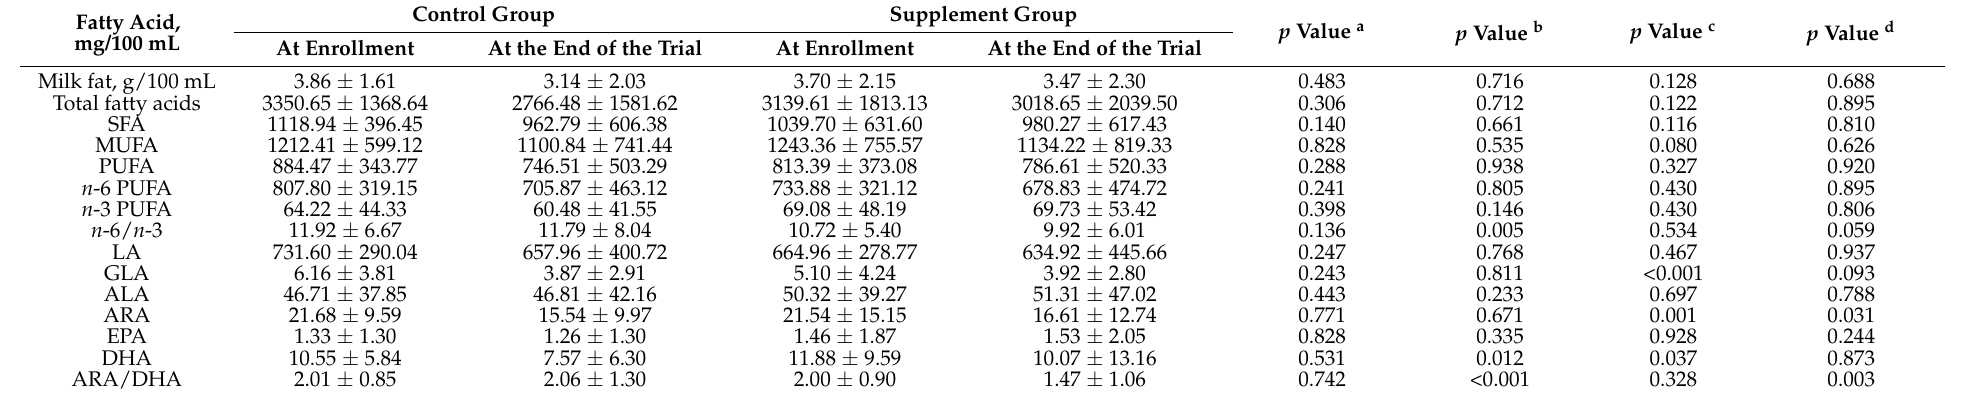
Table 3. The absolute concentrations of fatty acids in breast milk between the control and supplement groups at the time of enrollment and the end of the trial. Fatty Acid, mg/100 mL